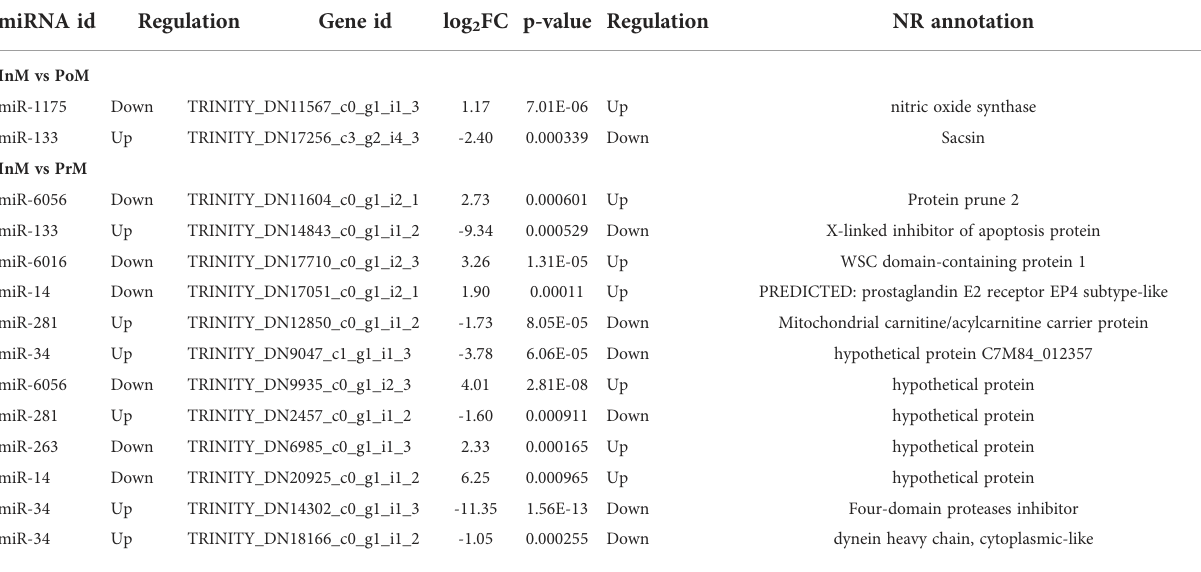
TABLE 2 The interaction networks of EVs miRNAs and mRNAs in S. paramamosain molt stages. miRNA id Regulation Gene